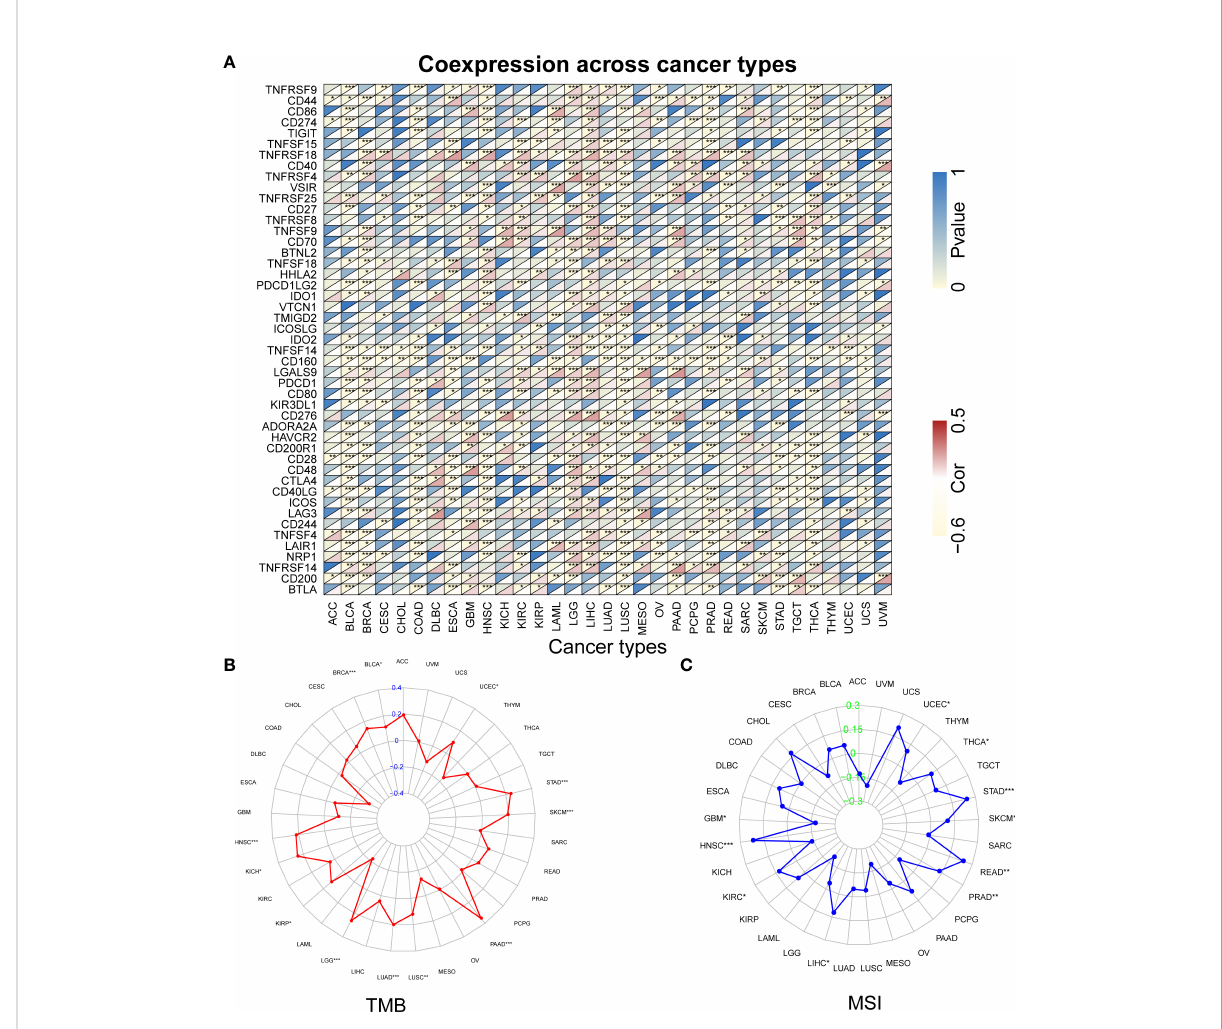
FIGURE 9 The relationship between RBX2 and immune checkpoints, TMB and MSI based on TCGA database. (A) Heatmap illustrating the relationship between RBX2 and known immune checkpoints. The top left triangle represents the P-value, and the bottom right triangle represents the correlation coef fi cient. Correlation between RBX2 and TMB (B) and MSI (C) . * P < 0.05, ** P < 0.01, and *** P <